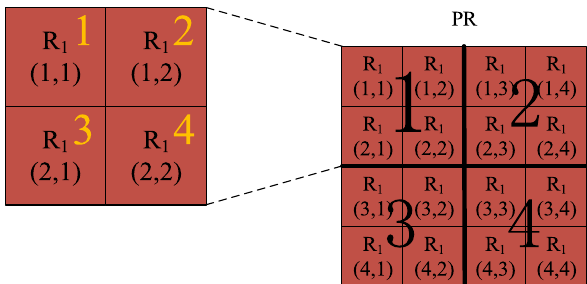
Fig. 4 Arrangement of the pixels within the block